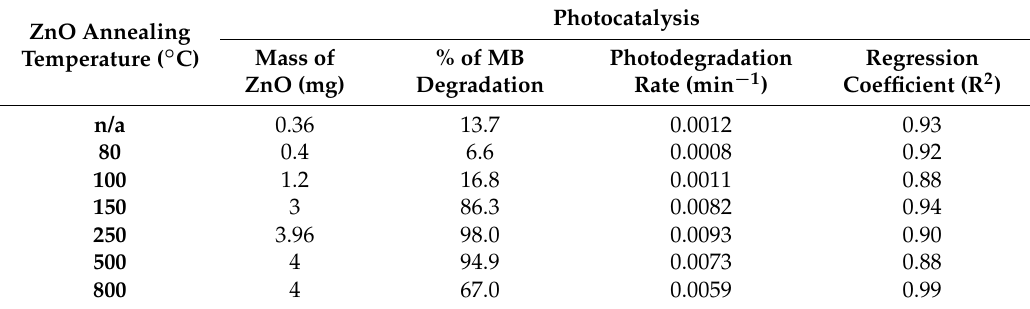
Table 3. Photocatalytic activity of ZnO samples representing the percentage of degradation of MB with the photodegradation rate and the relative regression coefficient.